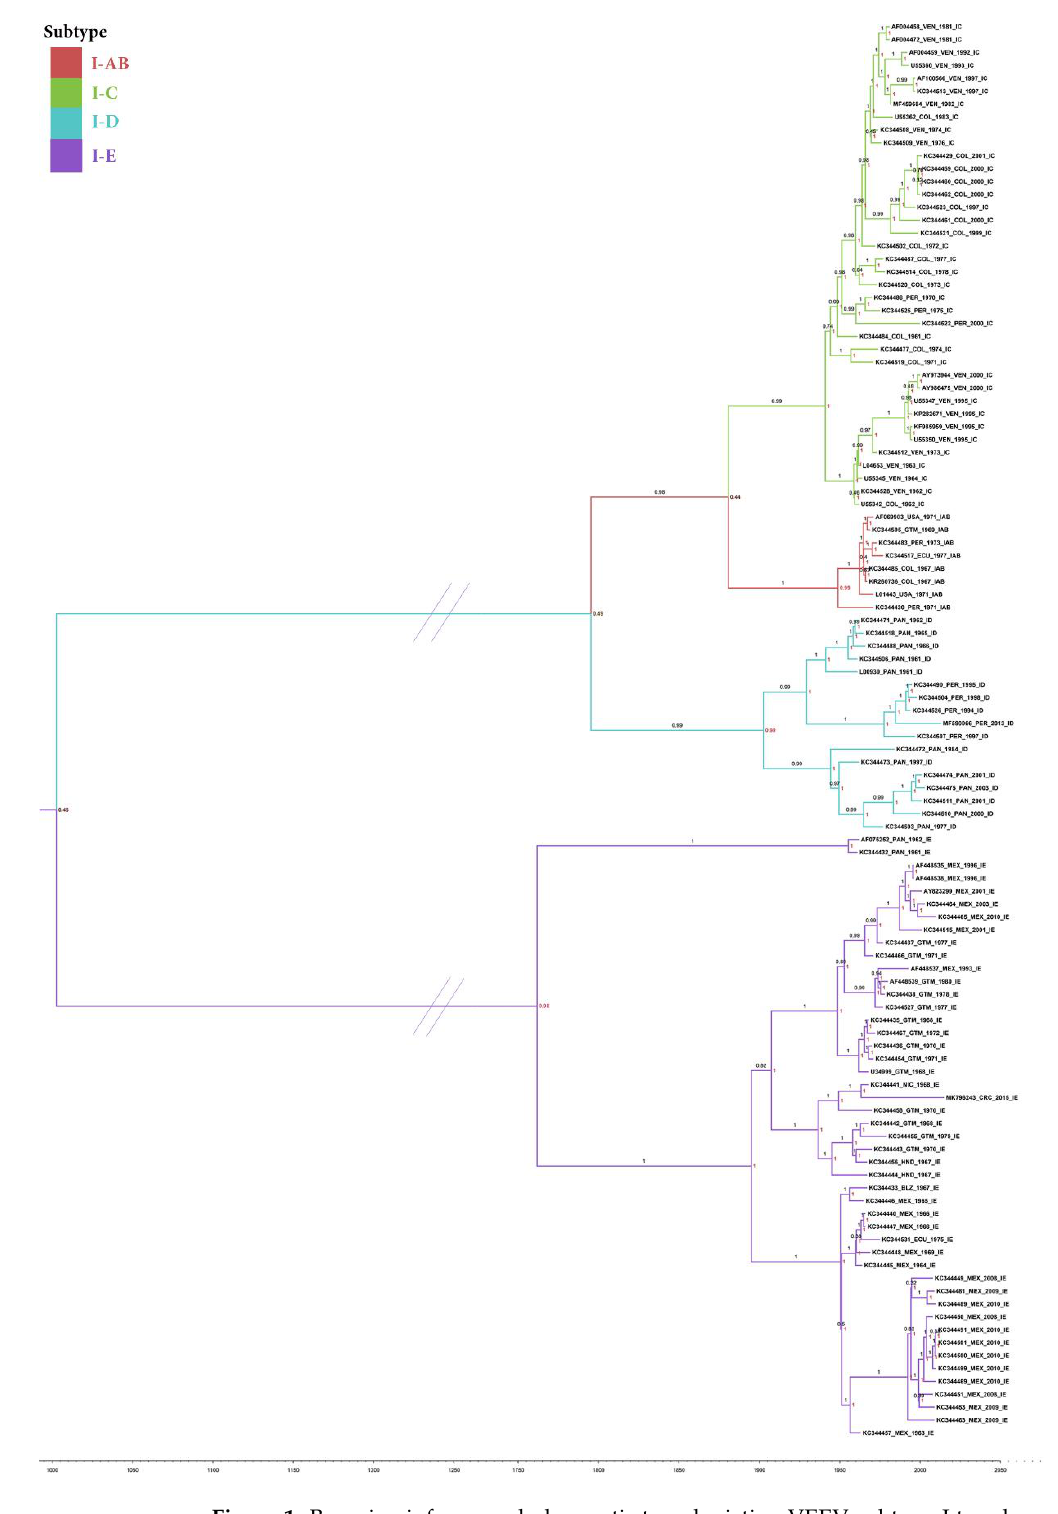
Figure 1. Bayesian inference phylogenetic tree depicting VEEV subtype I topology. Branch labels show the posterior probability, and the node indicates the probability of the subtype origin of the